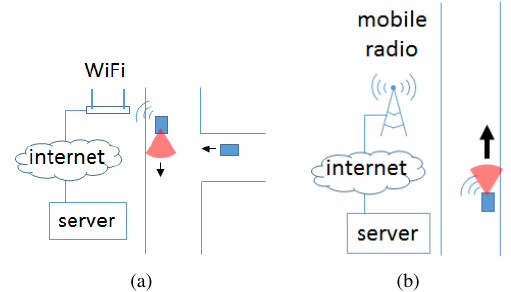
Figure 4: Techniques for wireless data transfer between vehicles and a server. The black arrows indicate the driving direction; the red circular segments indicate the field of view of a vehicle camera: a) WiFi, used for communication at low vehicle speed, e.g. at intersections, b) mobile radio, used at higher speeds or if WiFi is not